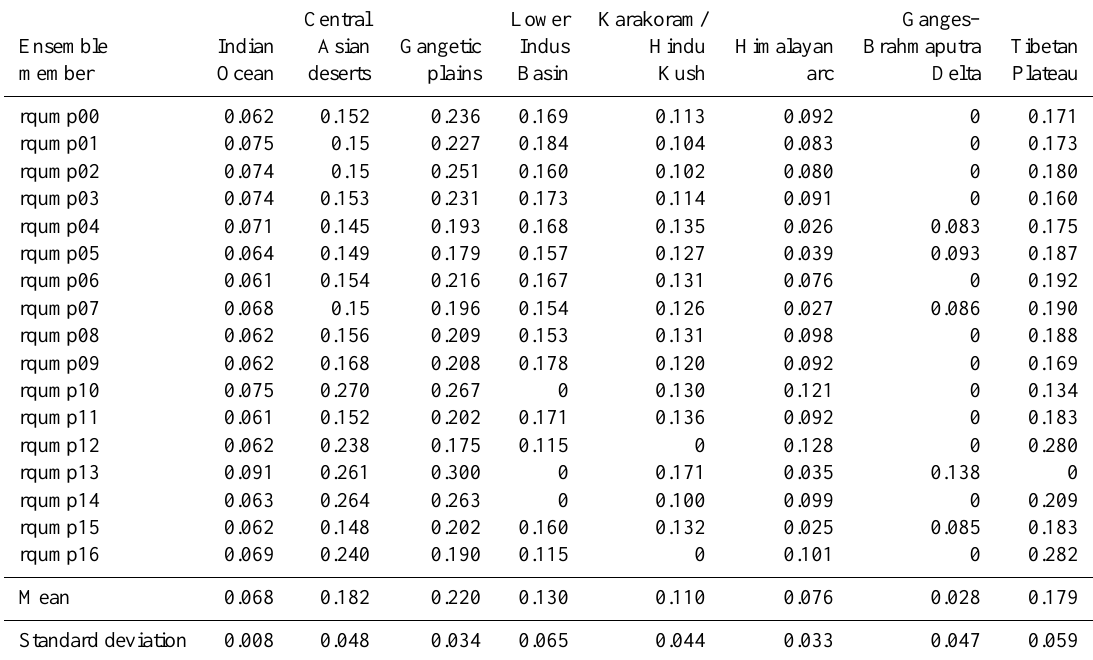
Table 5. Variability in primary Himalayan region climate zones (eight clusters) in the Hadley Centre downscaled perturbed physics ensemble, Regionally Quantify Uncertainty in Model Predictions (RQUMP), for South